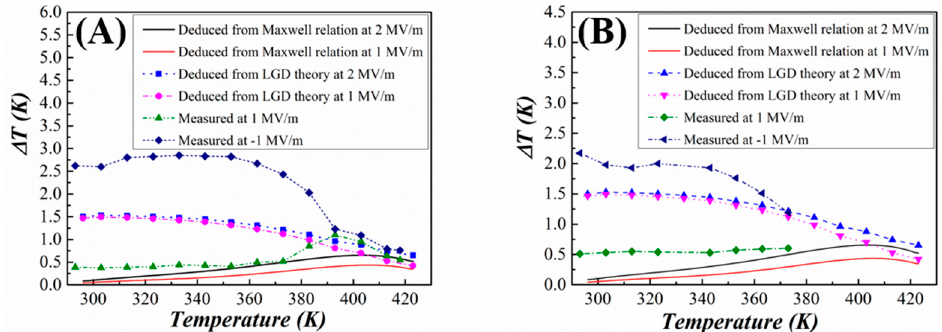
Figure 3. Temperature changes ( ∆ T ) for the [110] direction ( A ) and [111] direction ( B ) obtained from direct measurements, the Maxwell relation, and the LGD